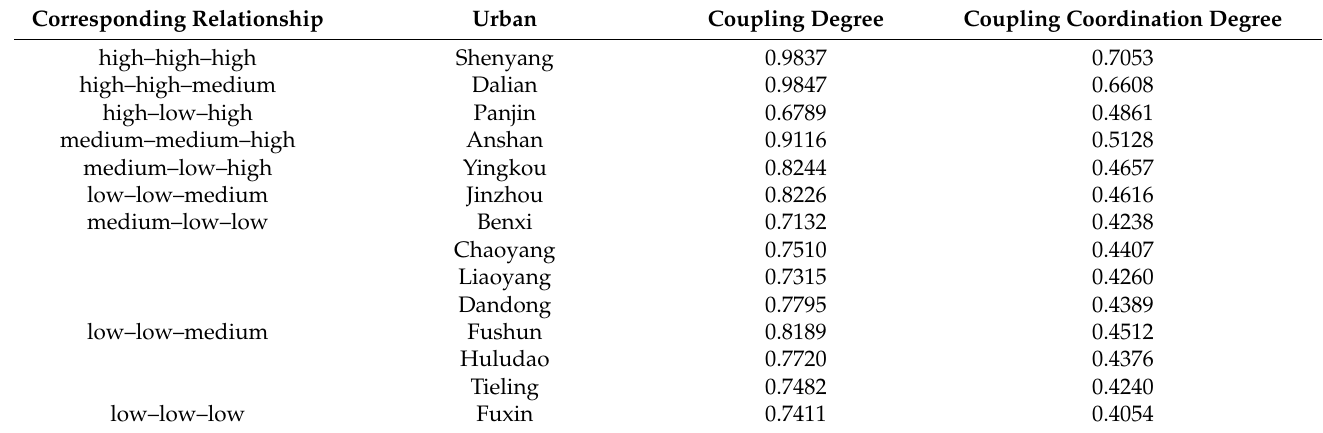
Table 2. Corresponding relationship, coupling degree and coupling coordination degree of “three states” coordinated development of high-quality human